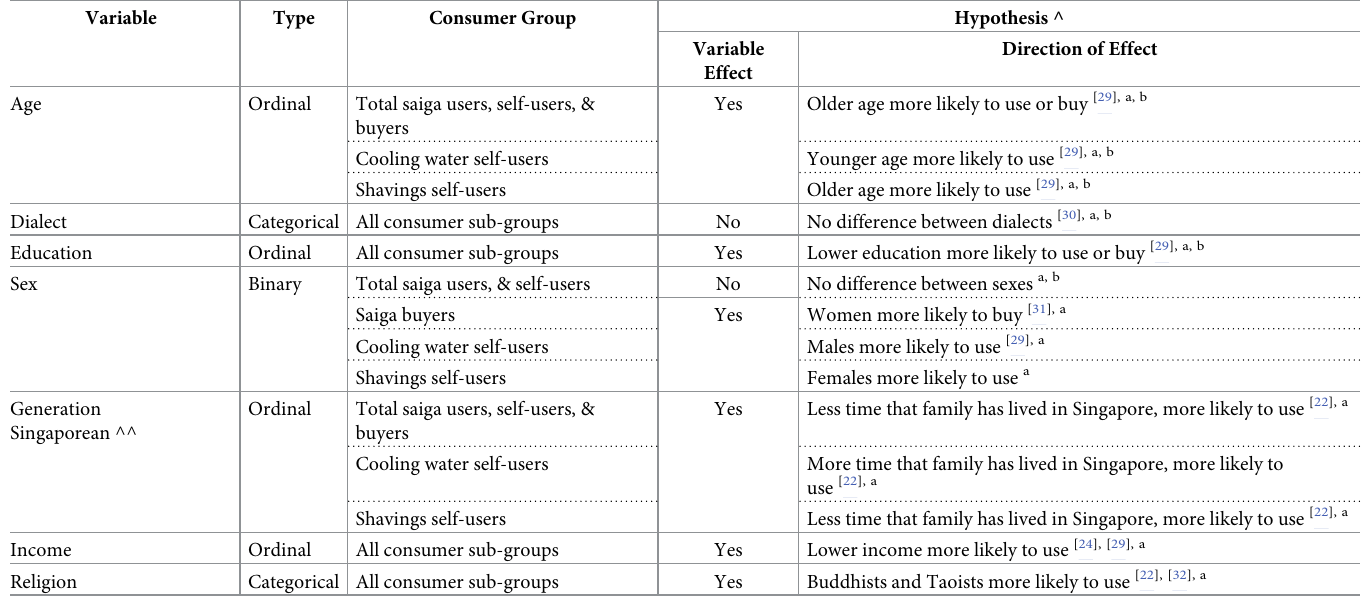
Table 1. Demographic variables used in regression analyses, along with their a priori hypothesised effects in each consumer sub-group.